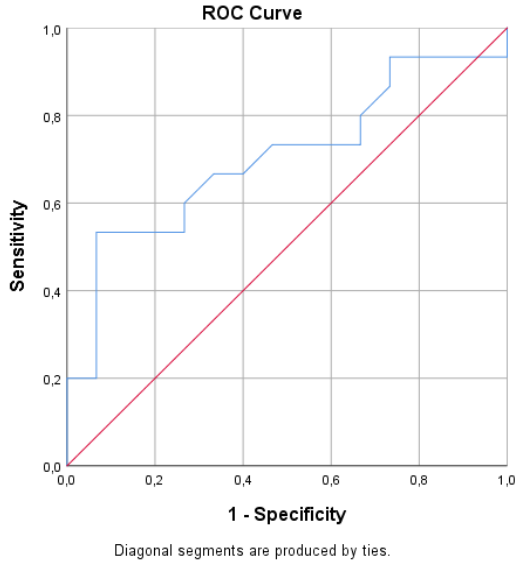
Figure 2. In ROC curve analysis, a cut-off value for Gal-3 of 7.42 ng/mL predicted PR Fraction >20% with specificity 93% and sensitivity 53% [AUC 0.704, ( p = 0.05)]. PCIII levels did not correlate with LGE scoring of RV, (Table 2).